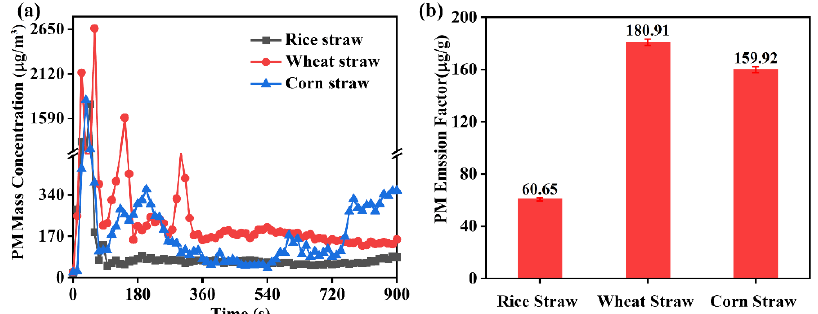
Figure 4. PM mass concentration ( a ) and emission factors ( b ) of the three crop straws.